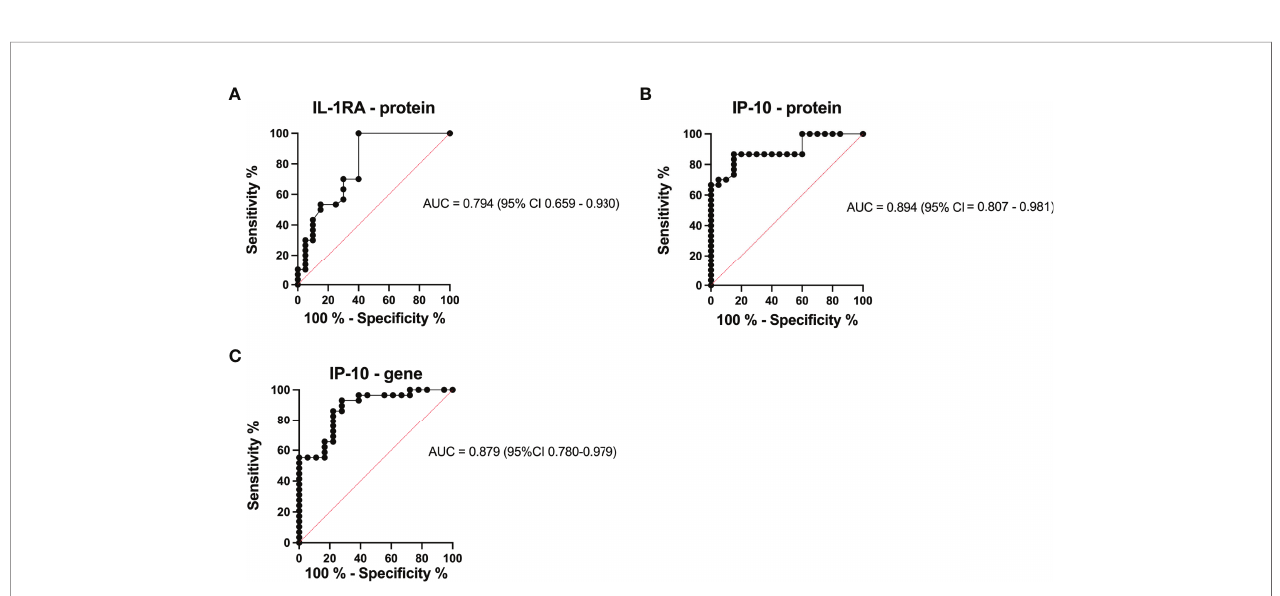
FIGURE 4 | ROC curve characteristics for IP-10 protein and IL-1RA protein as well as IP-10 mRNA, as discriminatory markers for TB. AUC, speci fi city, sensitivity, PPV, and NPV indicate the power of (A) IL-1RA protein abundance, (B) IP-10 protein abundance, and (C) IP-10 mRNA expression which are reported and indicate the power of these biomarkers for discriminating between those who are healthy and those with